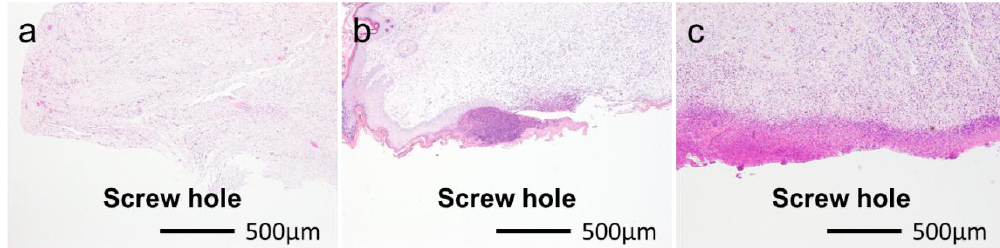
Figure 5. Typical histological appearances of inflammation in soft tissue along the pin tract four weeks after operation. Grade 0s: No inflammation ( a ); Grade 1s: Partial inflammation ( b ); Grade 2s: Severe inflammation ( c ).